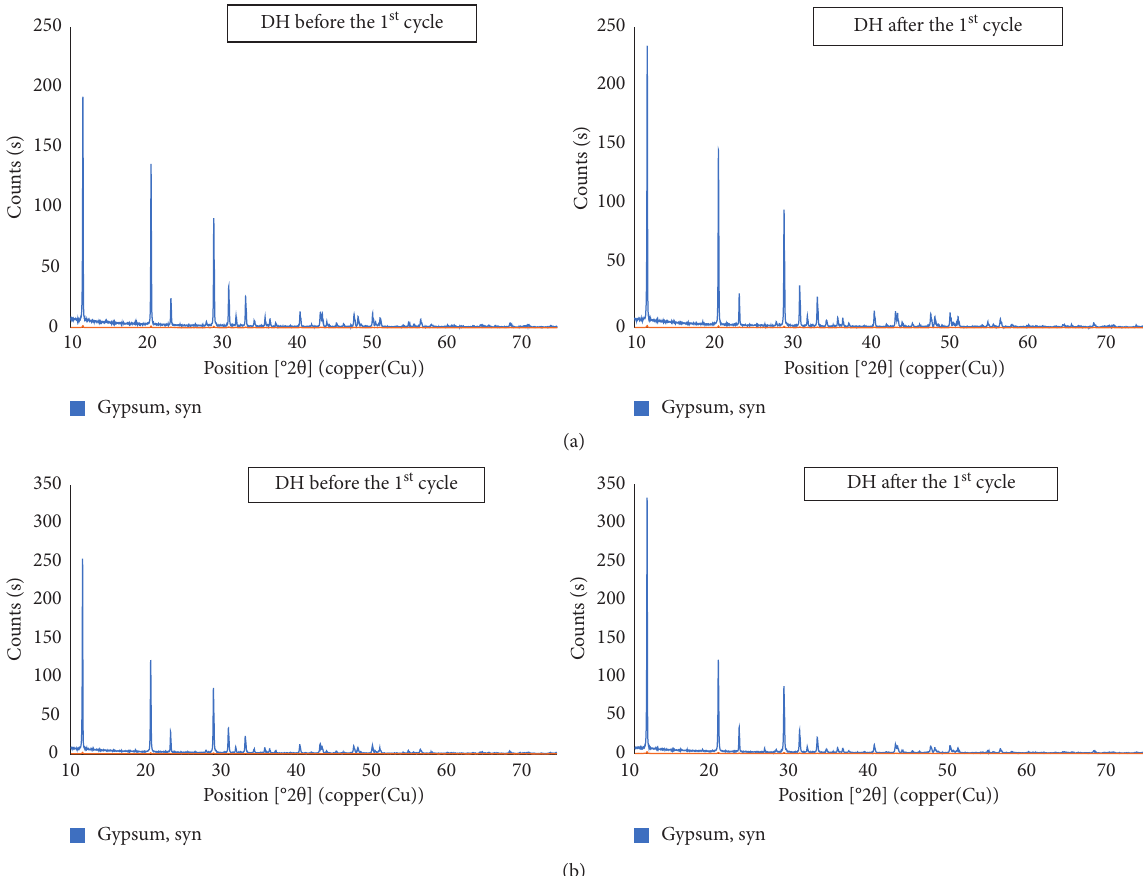
Figure 10: XRD patterns for the generated DH before and after the first hydration cycle from (a) β -HH and (b) α